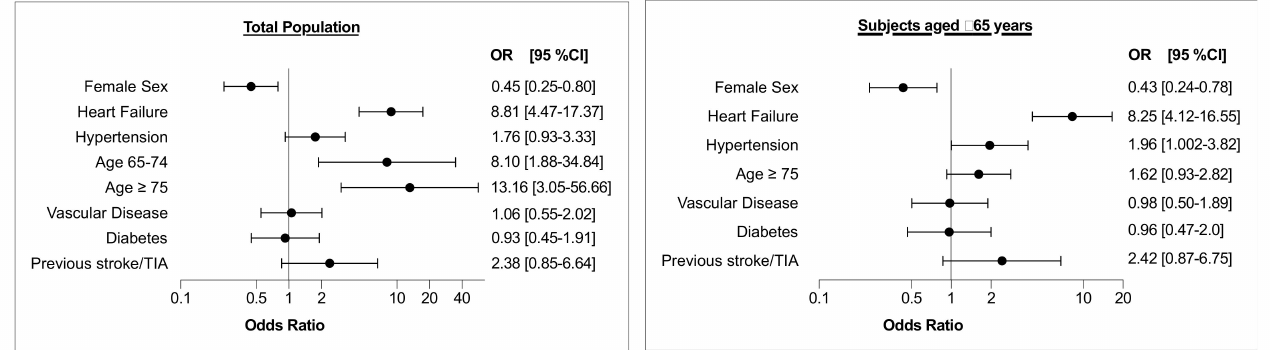
Figure 1. Results of multivariate analysis evaluating the characteristics of study participants with regard to screen-detected AF, as confirmed by 12-lead ECG. Vascular disease includes CAD, previous myocardial infarction and/or peripheral artery disease. Left panel: Total population; Right panel: Subset of subjects aged ≥ 65 years. TIA = transient ischemic attack; OR = odds ratio; CI = confidence interval.